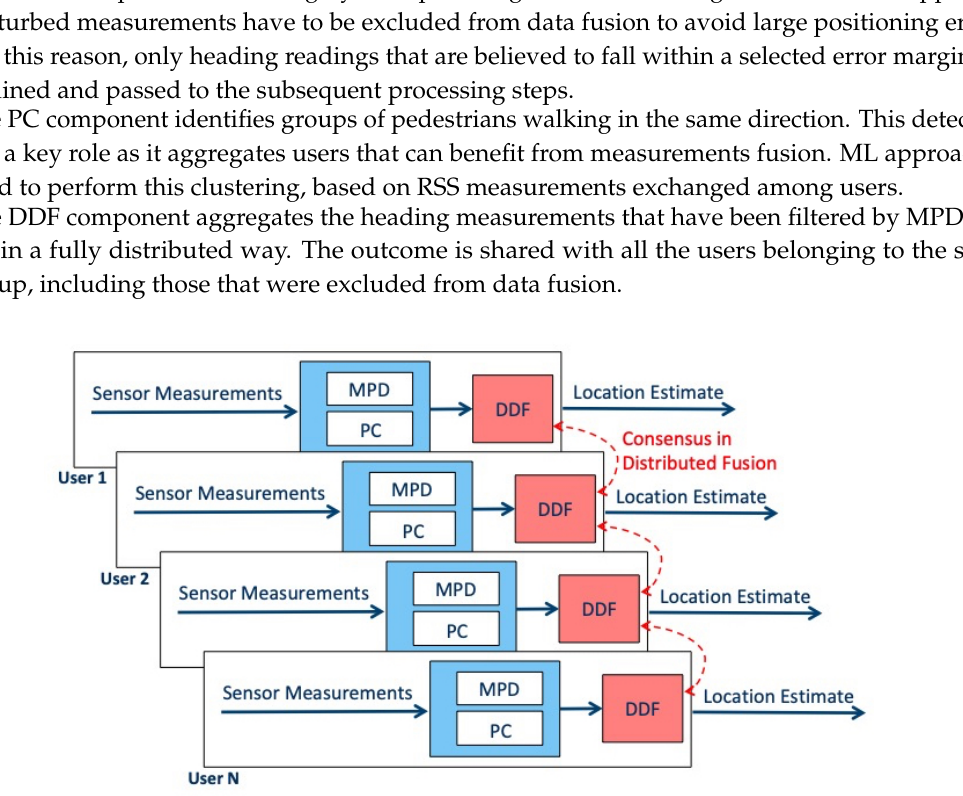
Figure 2. Cooperative Machine Learning PDR